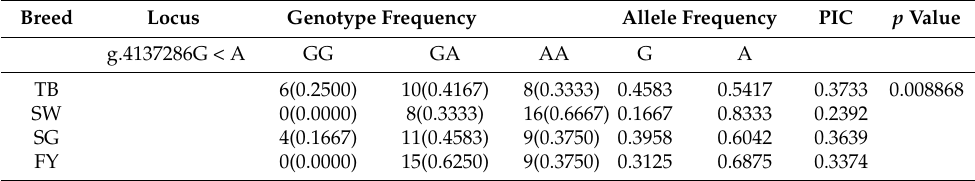
Table 5. Allelic and genotypic distribution of the TYRP1 gene in four rabbit breeds. Breed Locus Genotype Frequency Allele Frequency PIC